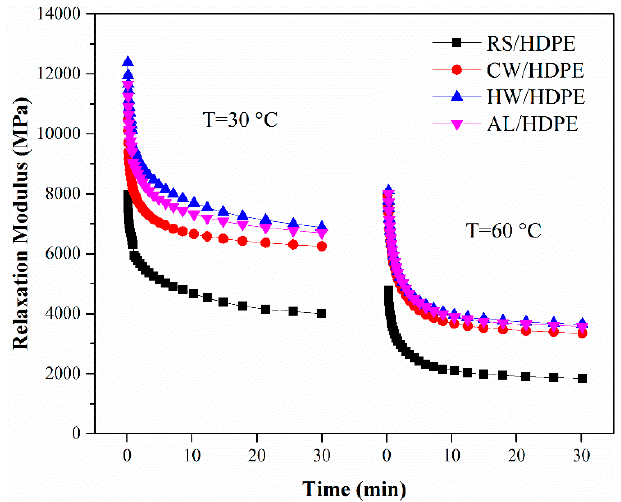
Figure 7. Stress relaxation of the RS/HDPE, CW/HDPE, HW/HDPE, and AL/HDPE at 30 and 60 °C, respectively.